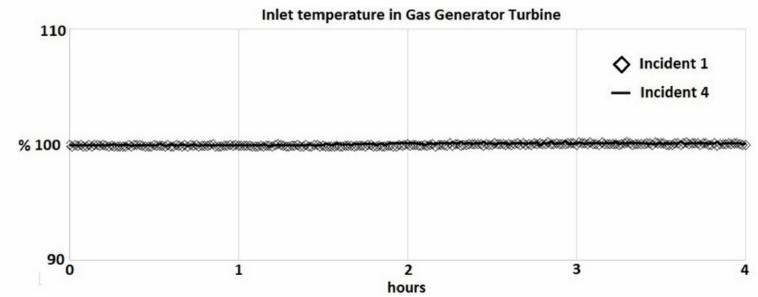
Figure 14. Normalised power output during Incidents 1 and 4.